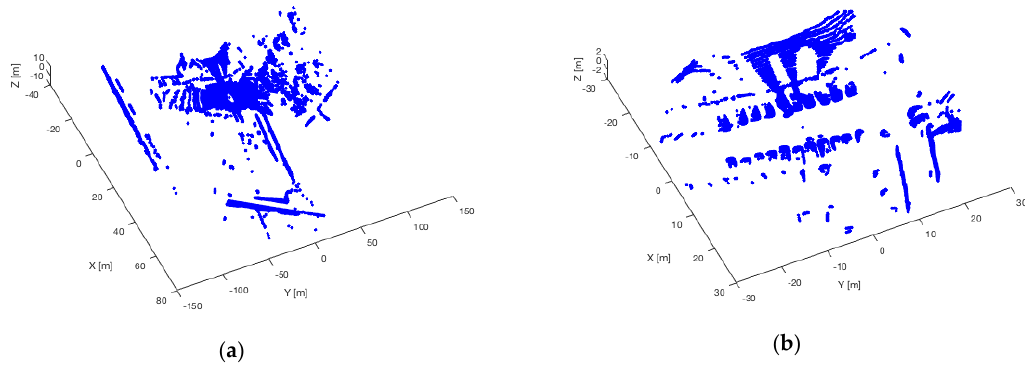
Figure 8. ( a ) Local map; ( b ) local filtered map.